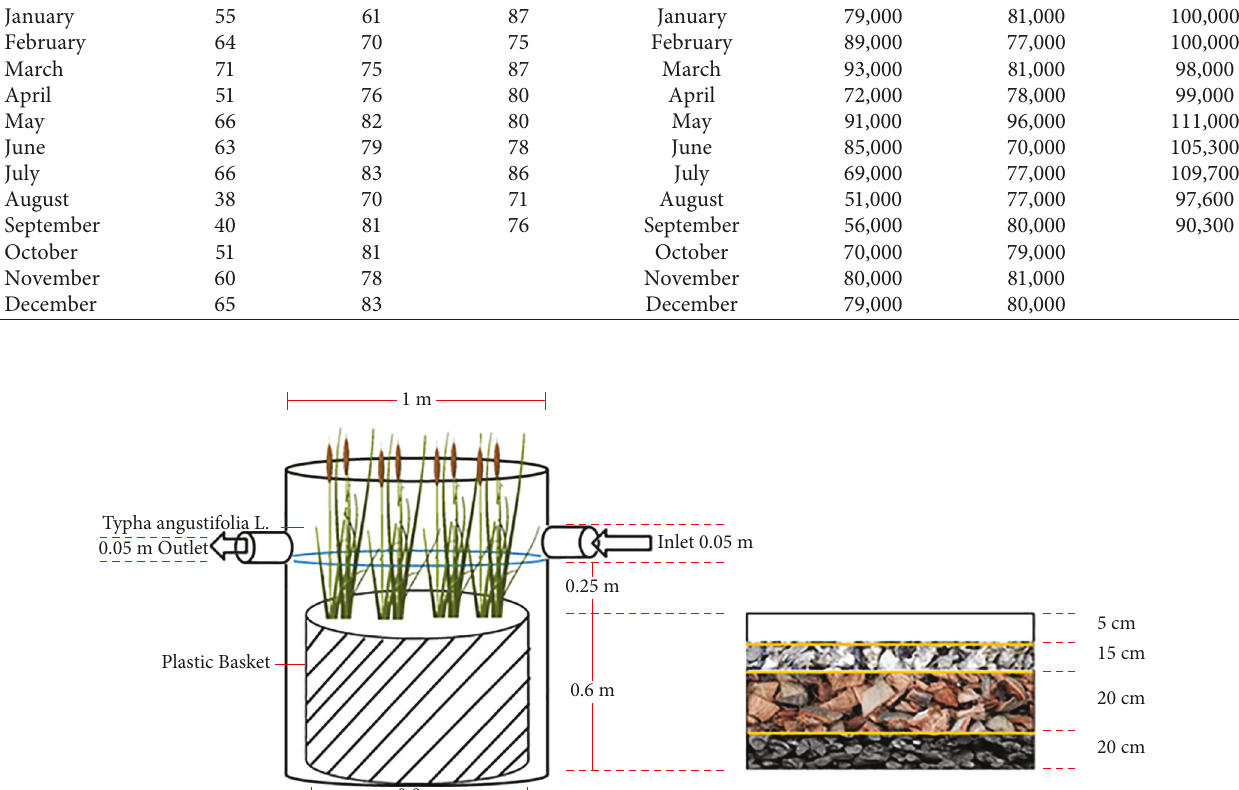
Table 1: The productivity of medical rubber gloves and its correlated wastewater per month in the years 2019, 2020, and 2021. Rubber gloves (million/month)